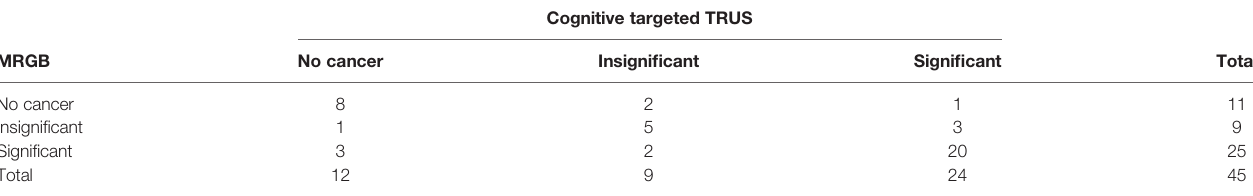
Cross-tabulation of biopsy outcome in men (n = 45) biopsied with MRGB and subsequent cognitive targeted TRUS. Signi fi cant cancer de fi ned as Gleason grade group ≥ 2. MRGB, MR-guided in-bore biopsy.